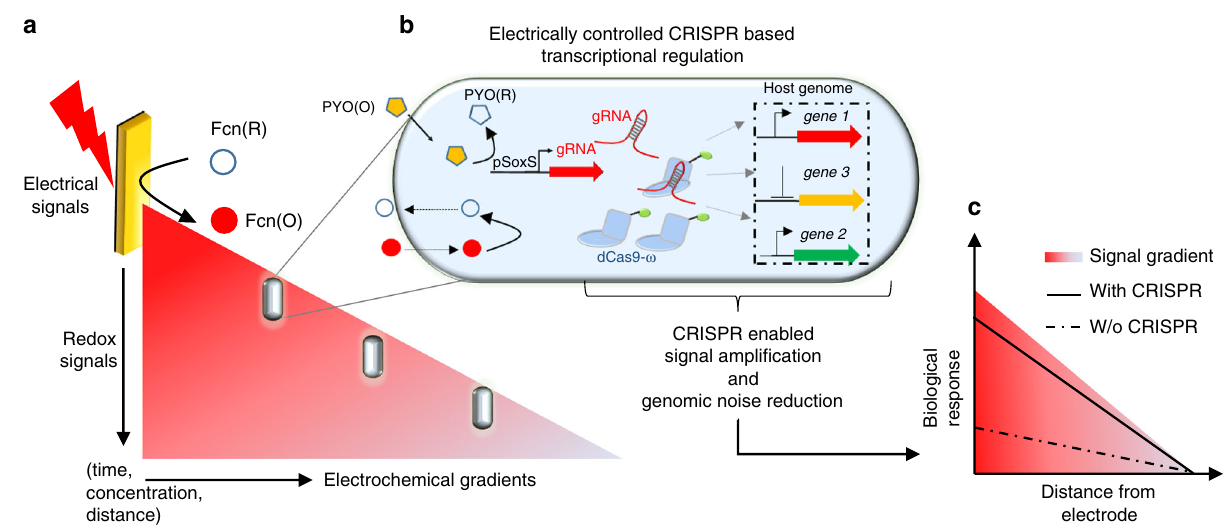
Fig. 1 Scheme of the eCRISPR system. a A scheme of the spatio-temporal electrochemical gradients generated at the bio-electronic interface where an oxidizing potential is applied via an external electrode to oxidize the Fcn resulting in generation of a Fcn(O) gradient across space and time away from the electrode. b The eCRISPR system comprising of the SoxS-based electrogenetic promoter is activated by pyocyanin (PYO) and the redox mediator ferricyanide Fcn(O), resulting in expression of gRNAs and the formation of CRISPR-based transcriptional factor complexes. These complexes can be directed to desired sites leading to properties of signal ampli fi cation and noise reduction in complex signal gradients at the bio-electronic interface. c Resulting effect of the eCRISPR based genomic regulation is that biological populations display more linear and ampli fi ed biological responses in response to signal gradients leading to higher signal fi delity across the bio-electronic